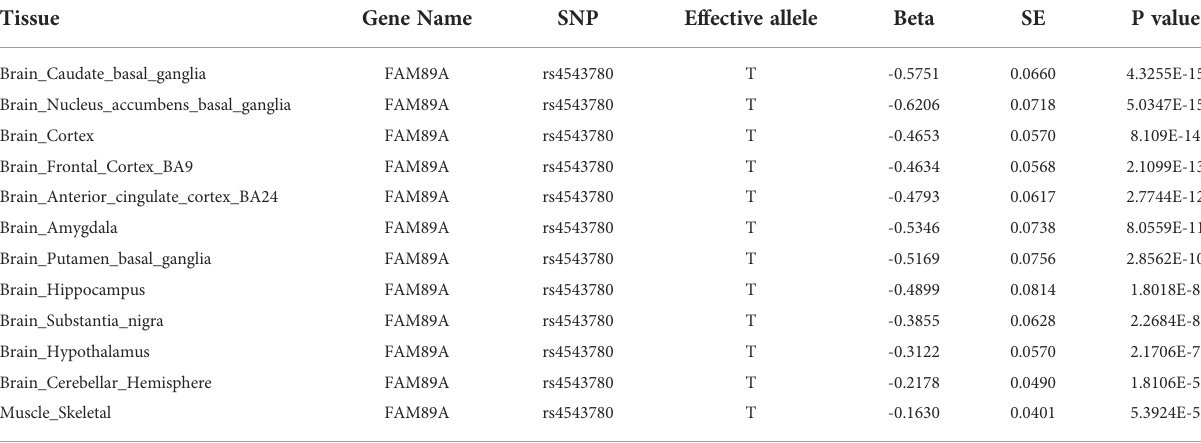
TABLE 4 Association between rs4543780 and FAM89A gene expression revealed by GTEx (V8) eQTL data.